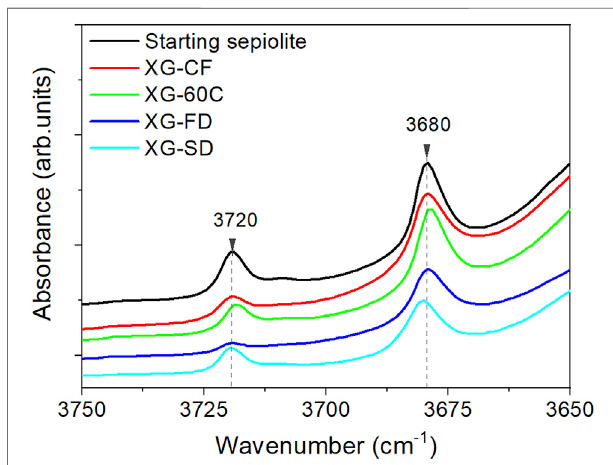
FIGURE 5 | FTIR spectra (3,750 – 3,650 cm − 1 region) of the sepiolite